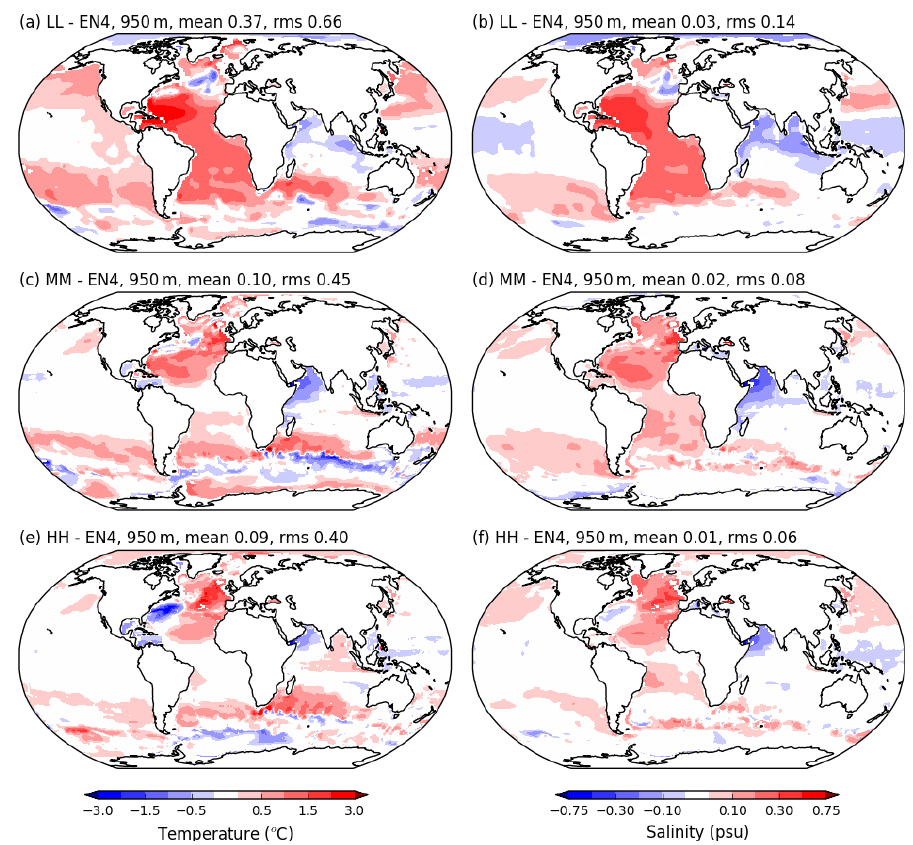
Figure 12. Biases at 950m depth at different model resolutions for (a, c, e) temperature and (b, d, f) salinity (model years 50–100 minus the EN4 mean for